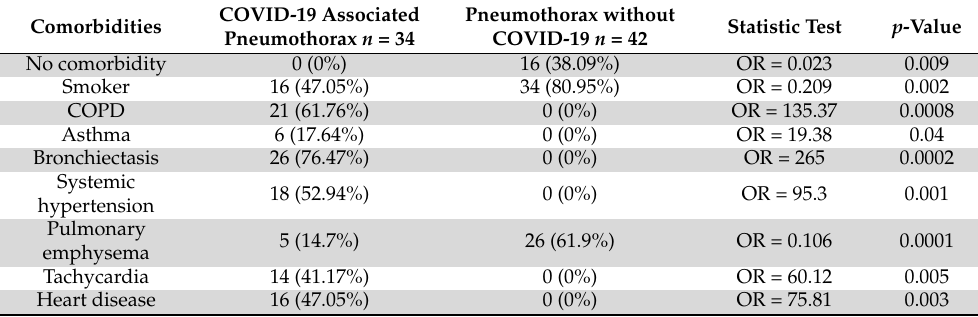
Table 2. Analysis of comorbidities per patient